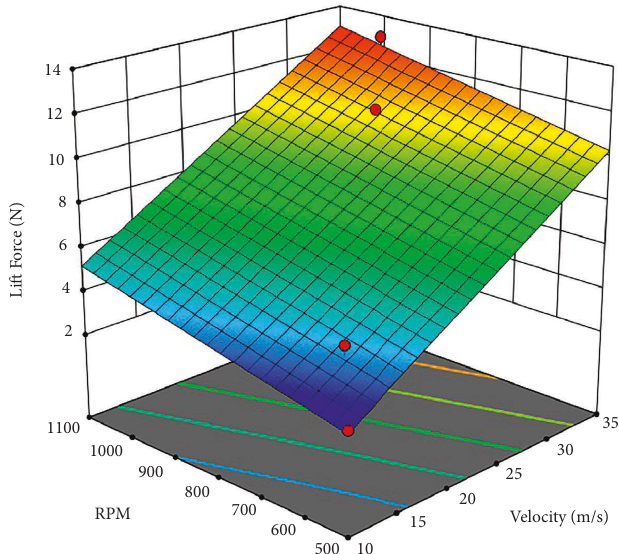
Figure 14: Lift force measured for the NASA SC(2)-0714 model.